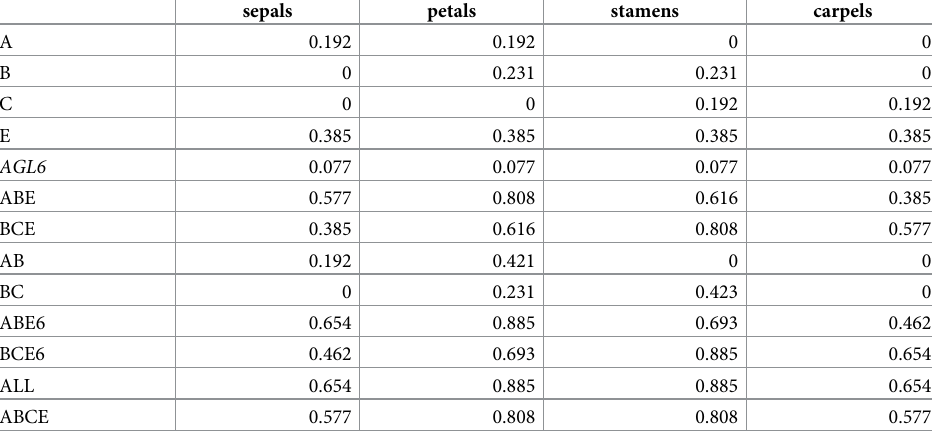
Table 1. The contribution values of the ABCDE and AGL6 genes.